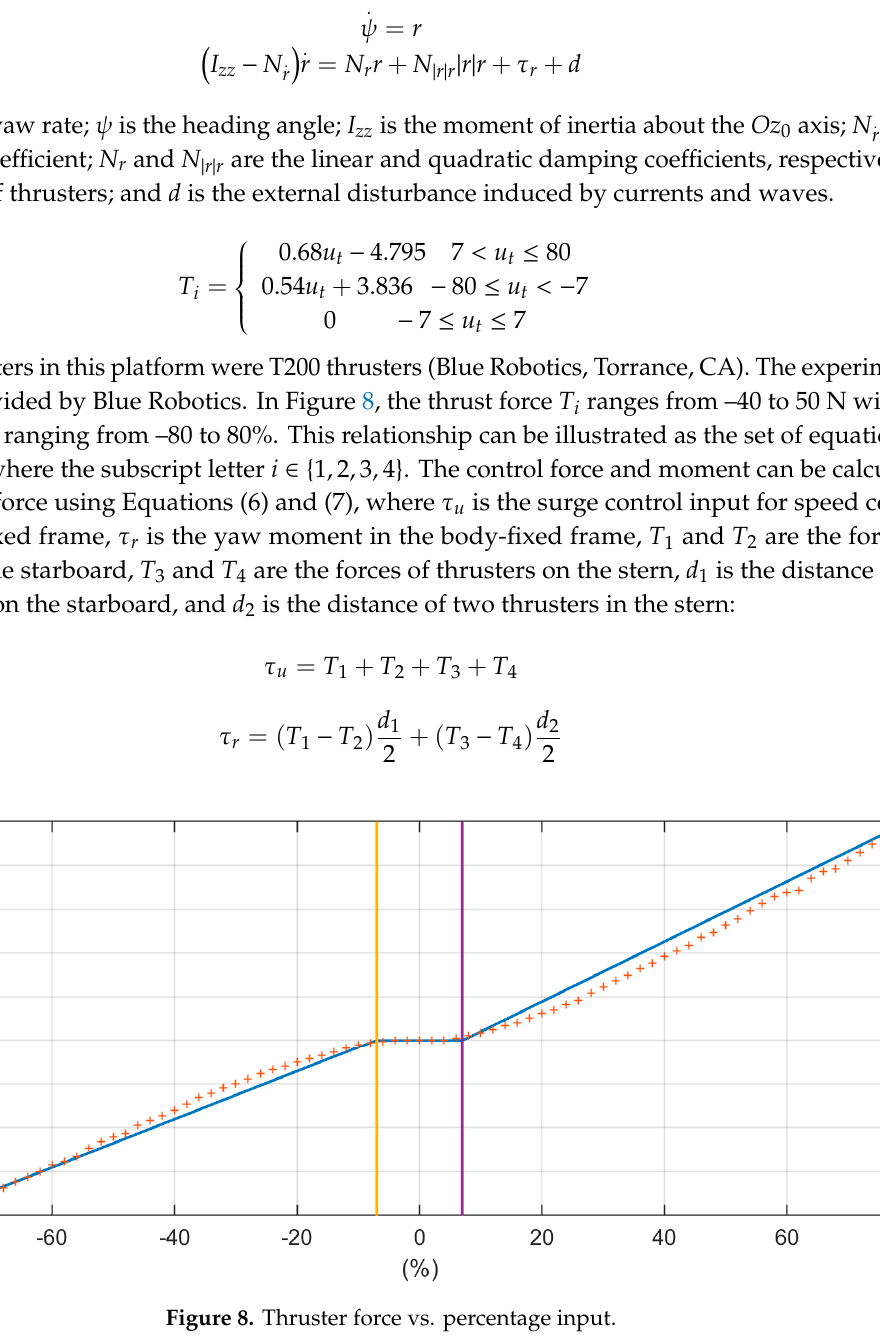
Figure 8. Thruster force vs. percentage input.